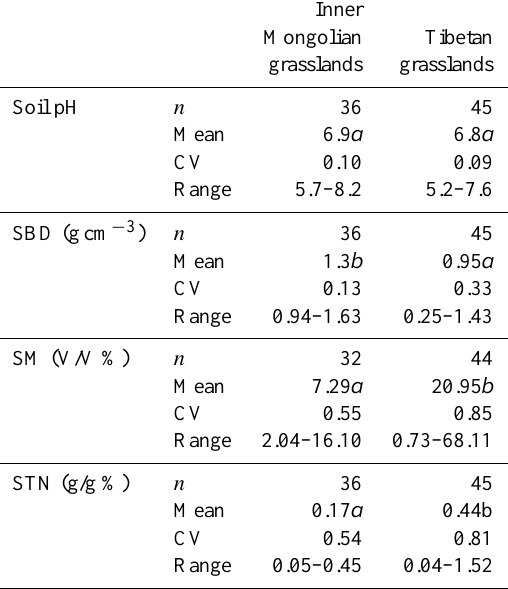
Table 2. Topsoil properties in the Inner Mongolian and Tibetan grasslands across sampling sites. Different letters indicate statistical significance at P < 0 . 05. SBD=soil bulk density; SM=soil mois- ture; STN=soil total nitrogen; CV=coefficient of variation. Inner Mongolian Tibetan